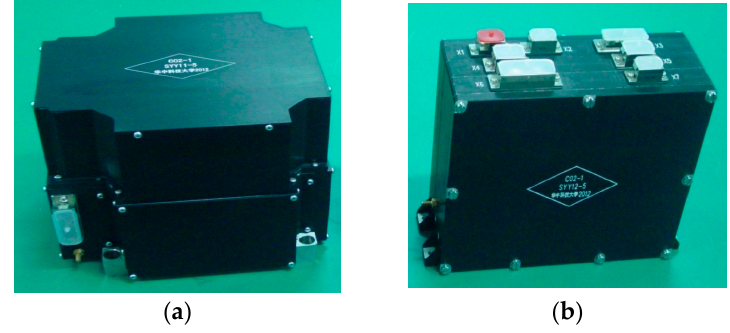
Figure 14. HSEA-I flight model: ( a ) sensor box and ( b ) electronics control box.